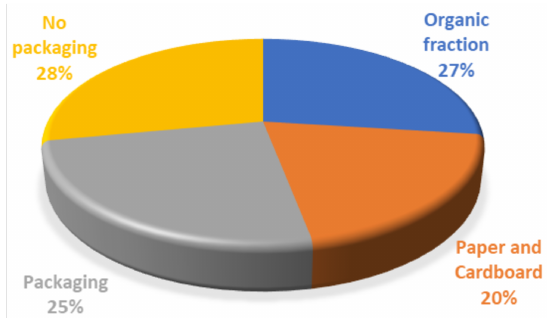
Figure 1. Characterization of the waste in fractions.